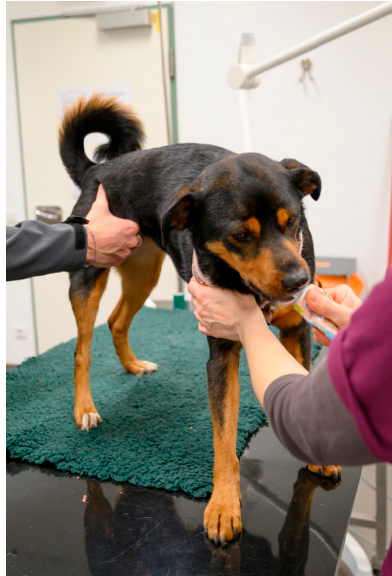
Figure 9. During counterconditioning, a potentially unpleasant or fear-inducing stimulus is paired with a high-value incentive. For optimal results, the start of the potentially aversive stimulus should precede the start of the positive desired stimulus, so that it becomes a predictor of something positive. Thus, the ideal sequence of events is as follows: start touch, then start feeding and continue feeding throughout the touch. When you stop touching, also stop feeding. Photo: Christine Arhant, Vetmeduni